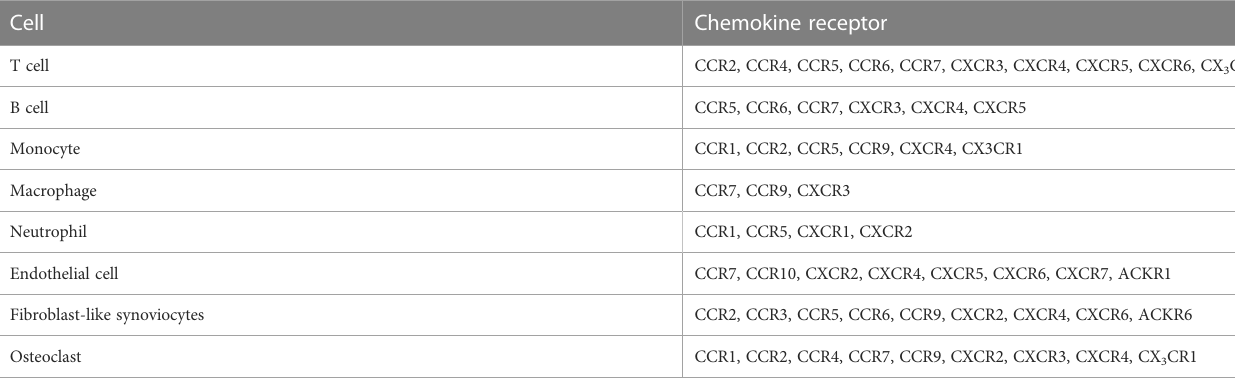
TABLE 3 The expression of chemokine receptors in RA patients.